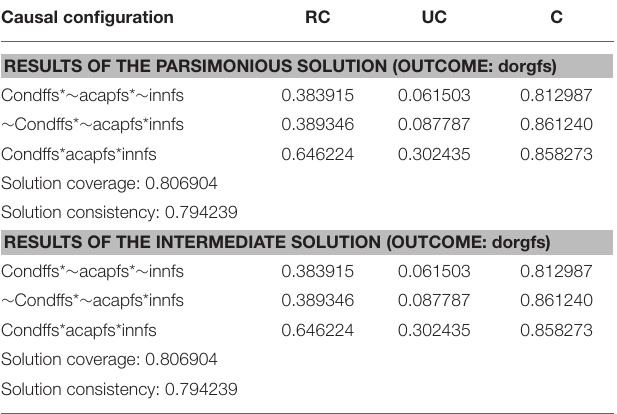
TABLE 8 | Results from fsQCA (truth tables).